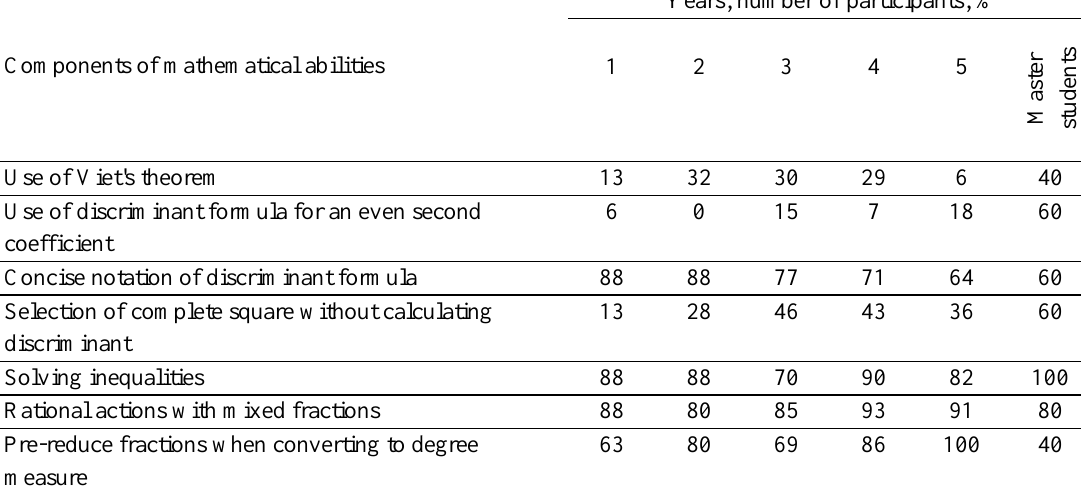
Table 3. Students 'answers to the question “What criteria can be used to assess the presence of mathematical